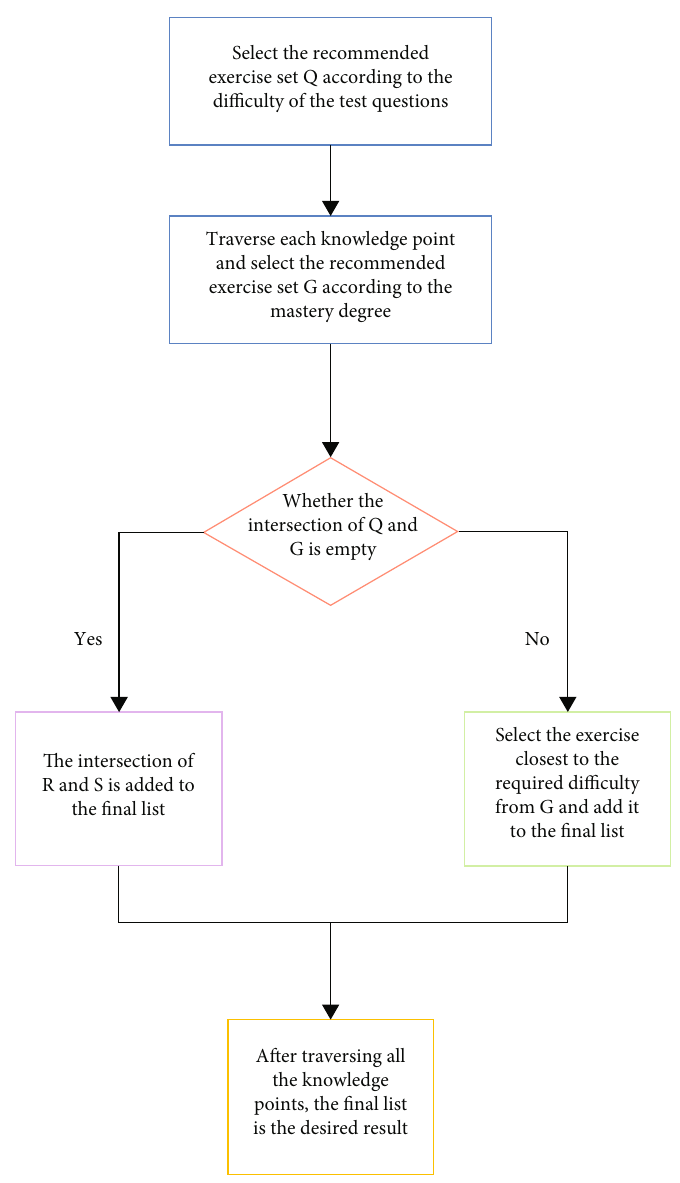
Figure 2: Exercise recommendation algorithm based on cognitive level and data